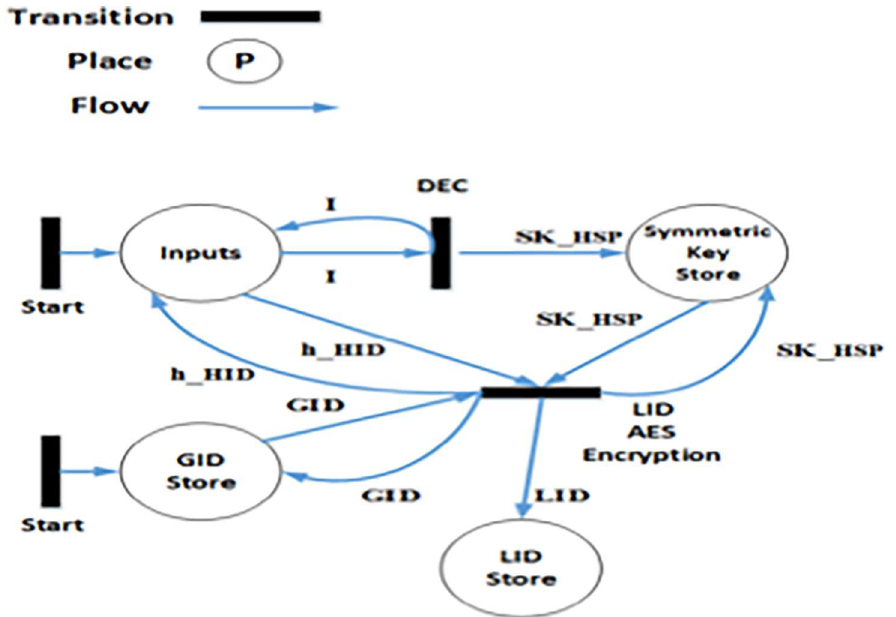
Fig 5. Algorithm 2: Generation of LID (Petrinet).